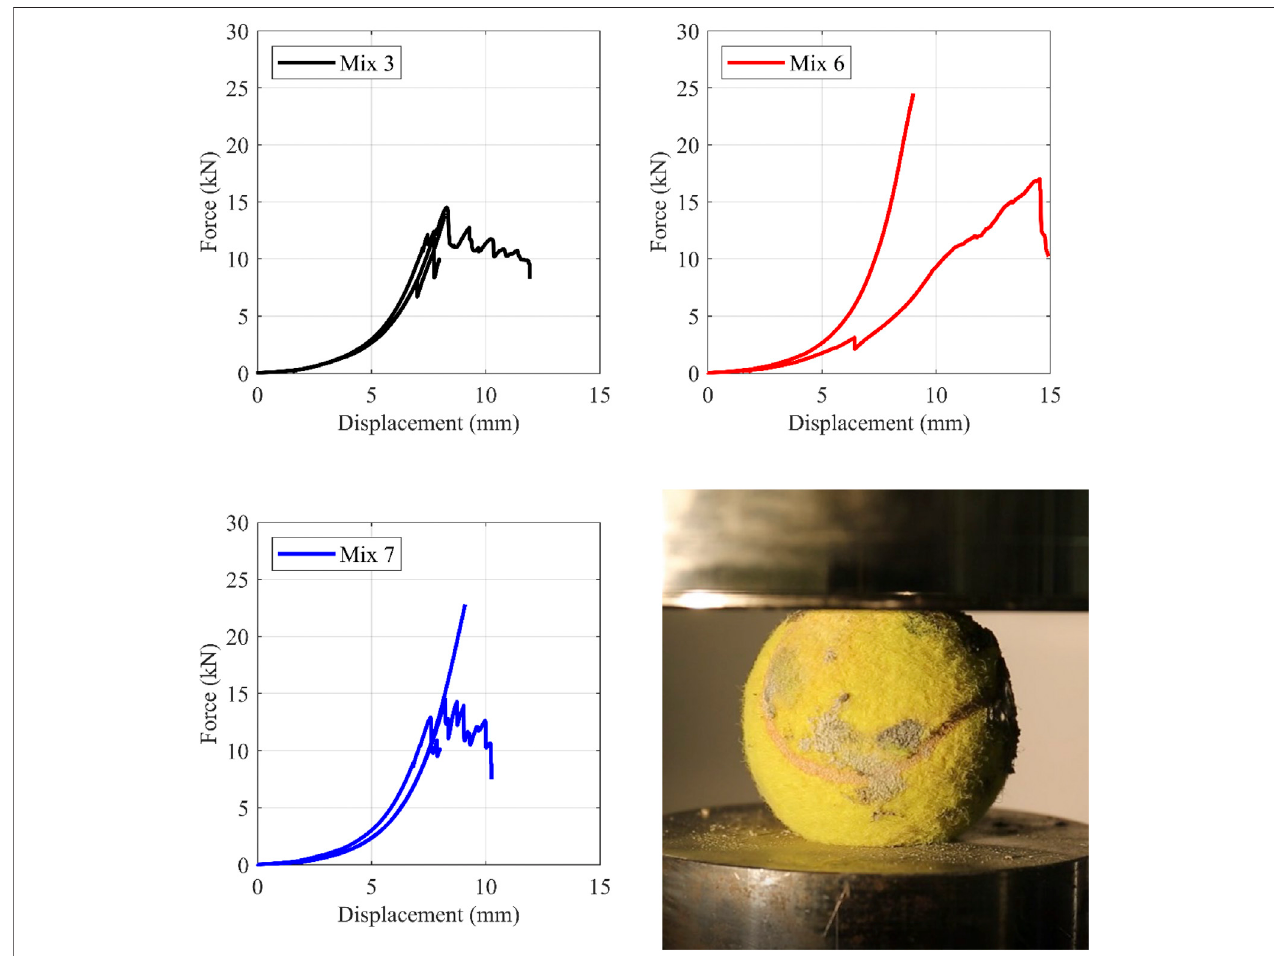
FIGURE 5 | Compressive behavior of the three selected cementitious mixes. Top-Left , Mix 3; Top-Right , Mix 6; Bottom-Left , Mix 7; Bottom-Right , TBI under compression between steel plates.